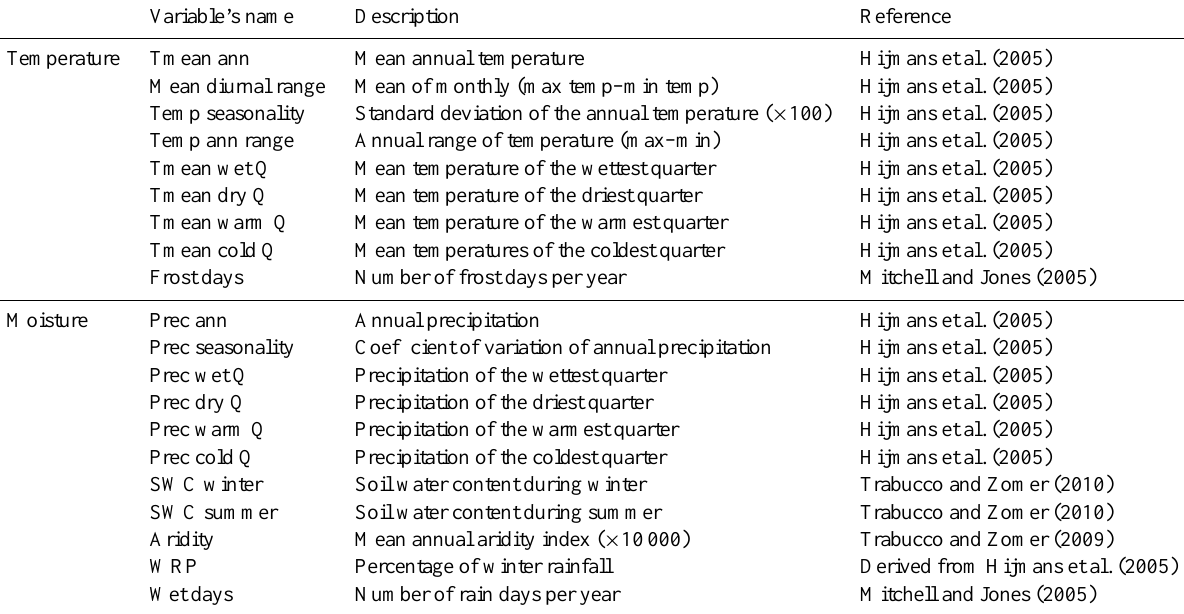
Table 1. List of the 20 climate variables reconstructed for southern Africa (name, description and original